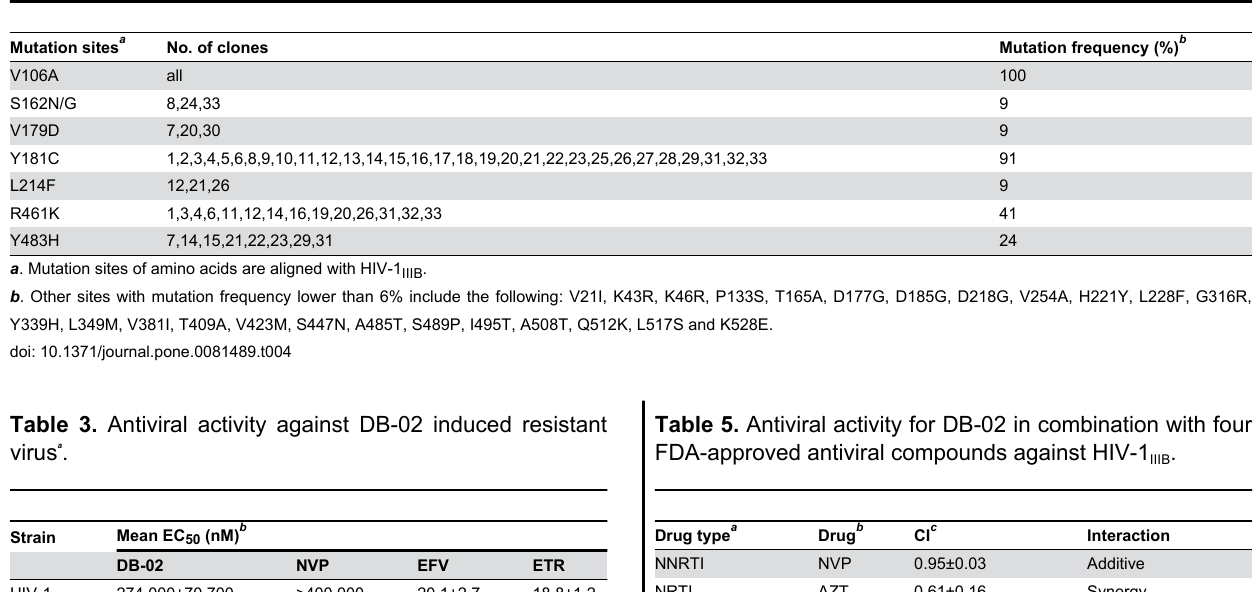
Table 4. Genotypic patterns of HIV-1